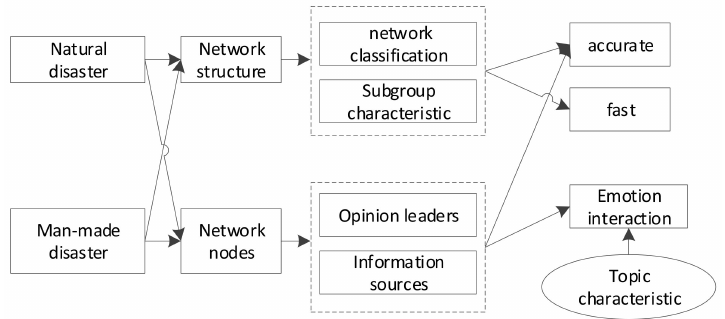
Figure 2. Conceptual Model on How Social Media Impacts Risk